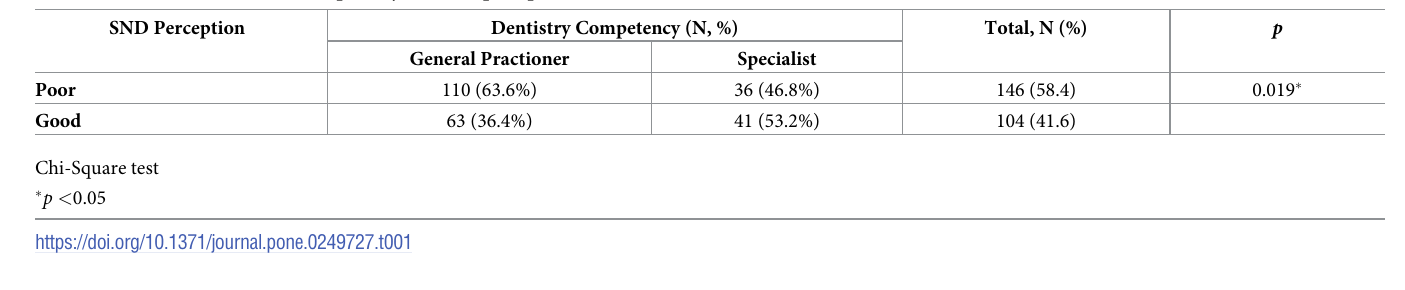
Table 1. Distribution of dentist competency and SCD